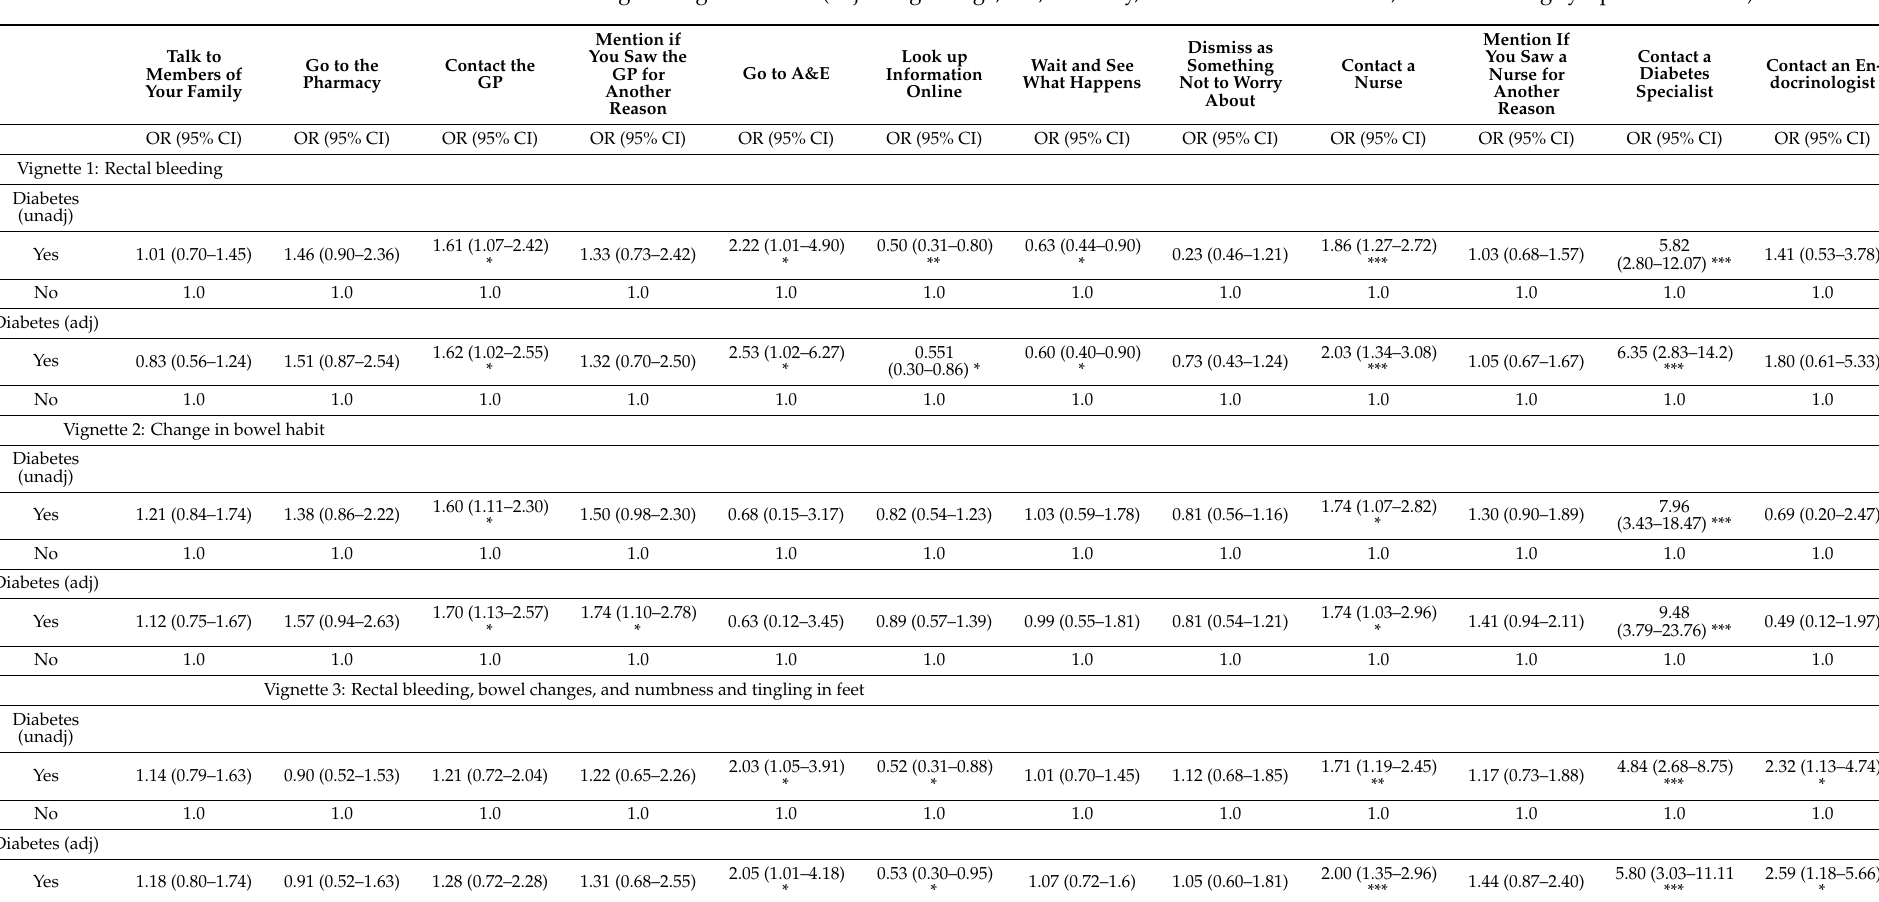
Table 2. Intended help-seeking behaviours (“definitely would” and “probably would” vs. “probably/definitely wouldn’t”) in response to potential CRC symptoms: univariable and multivariable logistic regression OR (adjusting for age, sex, ethnicity, number of comorbidities, and attributing symptom to